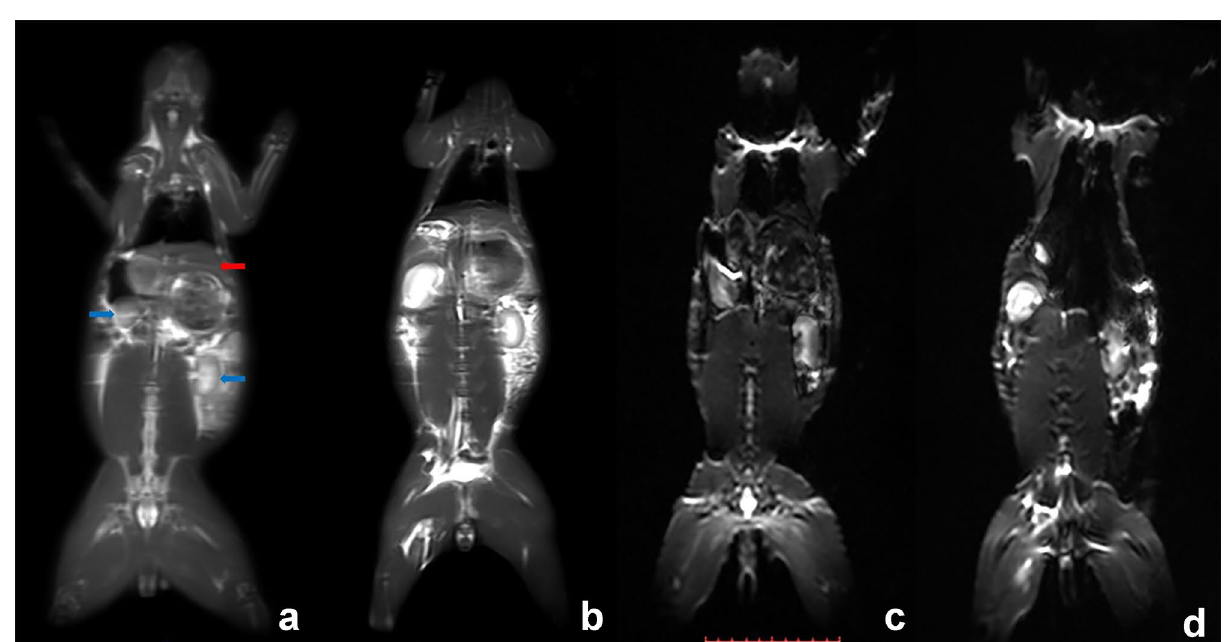
Figure 4. (a,b) The MRI T2WI image of the rabbit restrained by the fixator (a) or under anesthesia (b) . It clearly shows the main anatomical structure. such as the liver (red arrow) and kidney (blue arrow). (c,d) DWI image using EPI sequence for the rabbit with the fixator (c) or under anesthesia 6.43, P = 0.318 in the Bland–Altman plot; SUV value: arithmetic mean − 2.838, 95%CI 7.38 to 1.70, P = 0.190 in the Bland–Altman plot; MR T2 signal: arithmetic mean 0.617, 95%CI 0.83 to 2.06, P = 0.359 in the Bland–Alt- man plot).